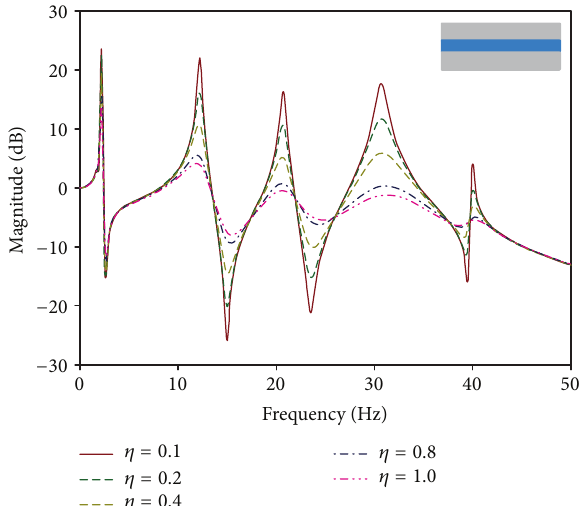
Figure 7: Frequency responseof cylindrical aluminum panel in case of SSDL with variety of central angles 𝜙 ( 𝑎 = 0.2 m, 𝑅 = 20 m, = 5 mm, 𝑡 = 2 mm, 𝑡 = 5 mm, and 𝜂 = 0.1 ). 𝑡 1 2 3